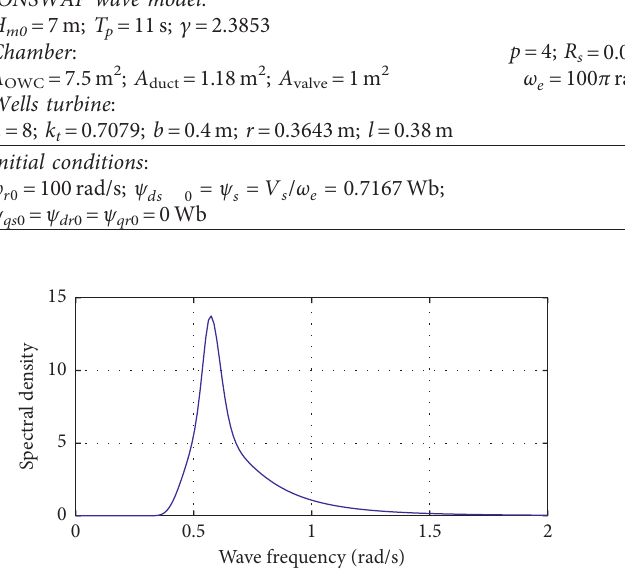
Figure 2: JONSWAP wave spectrum.